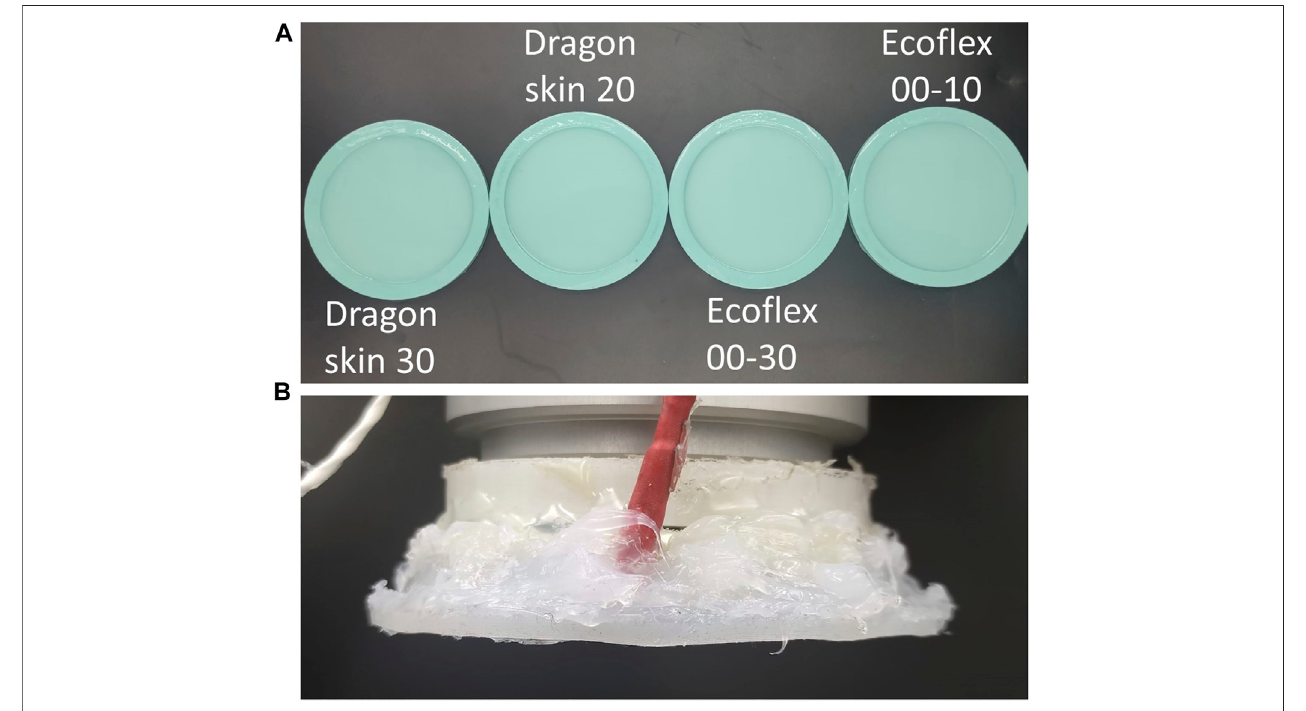
FIGURE 2 | Fabricated elastomeric fi lters in different materials (A) and implementation of the fi lter on the end-effector of the robotic arm (B) .